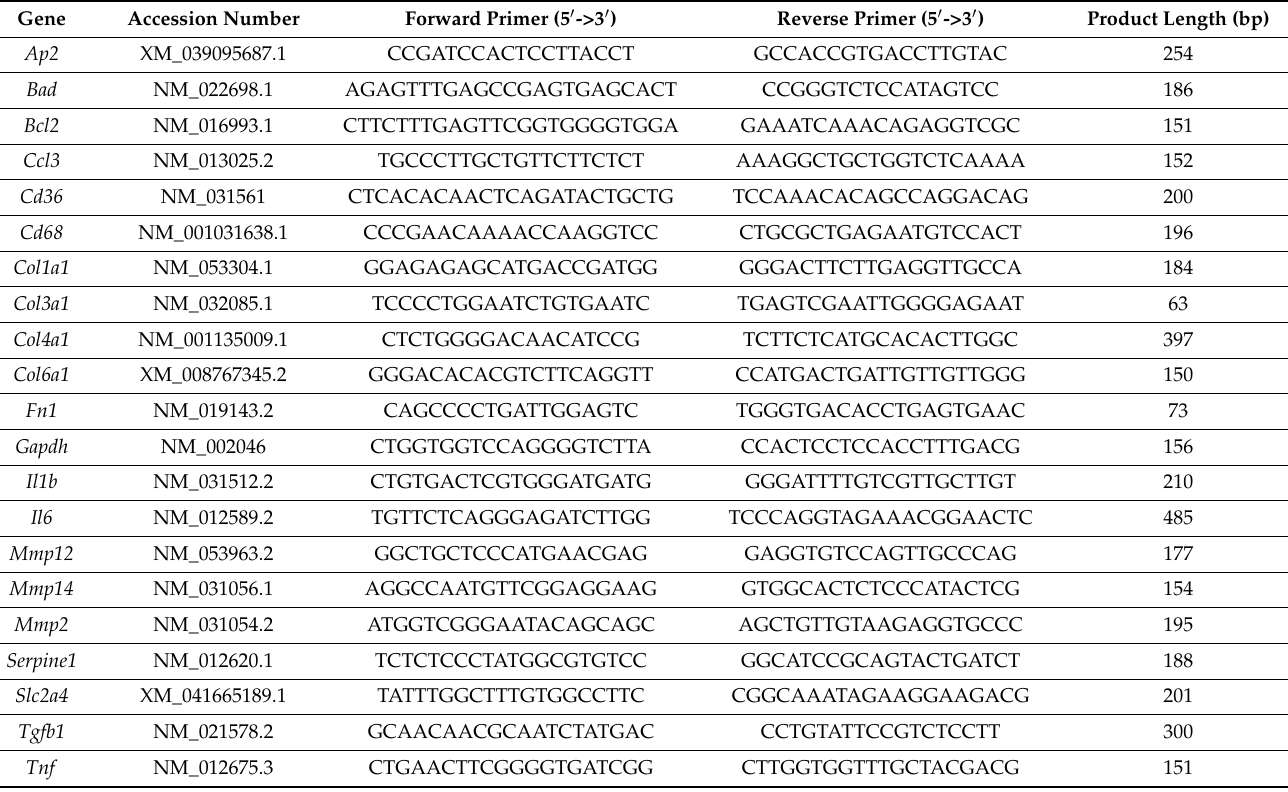
Table 1. Oligonucleotide primer sequences used in real time PCR amplification and product length.